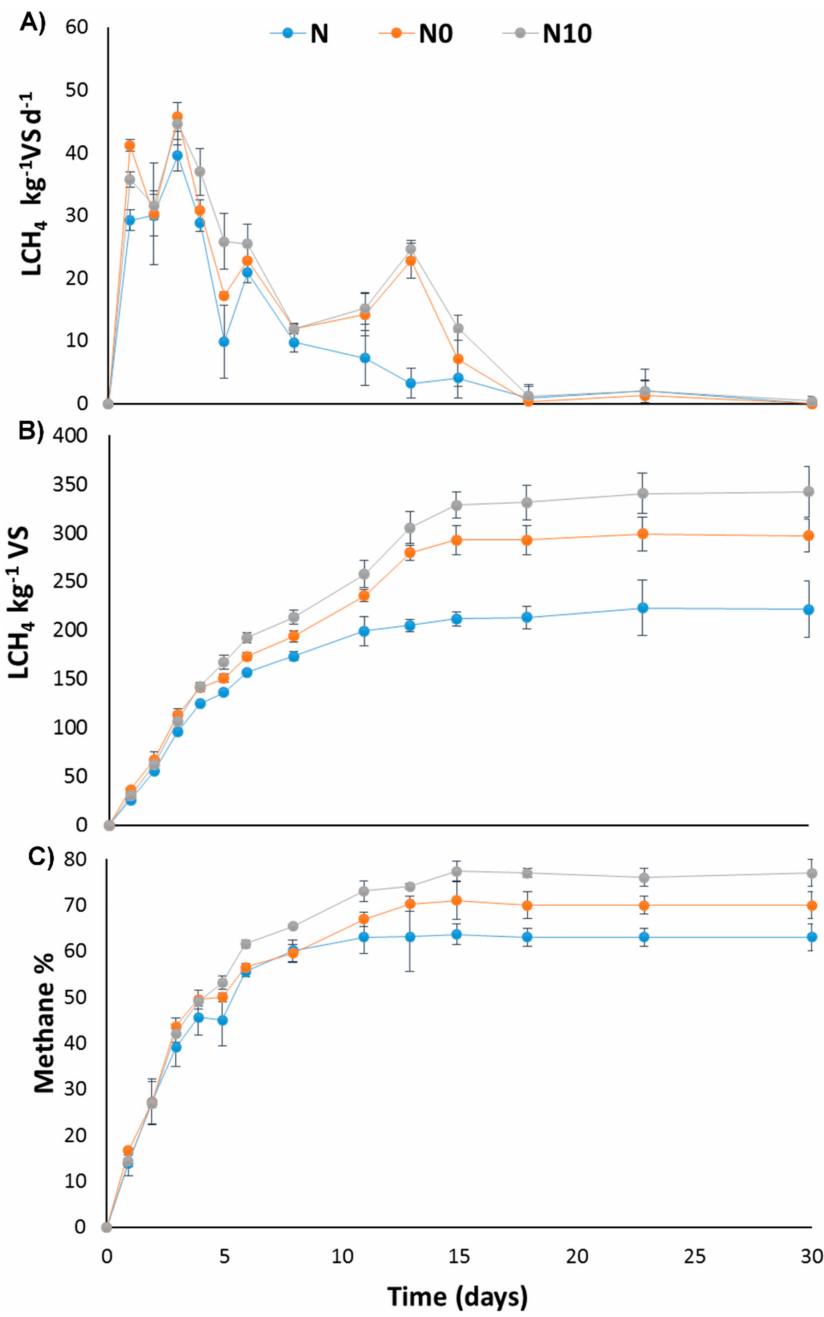
Figure 1. Biochemical Methane Potential (BMP) curves for control reactor (N), reactors with granular activated carbon (GAC) (N0) and reactors with biofilm GAC developed before undertaking the BMP test (N10). ( A ) Daily methane production ( B ) Cumulative methane production ( C ) methane biogas percentage. Mean values ± SD from triplicate